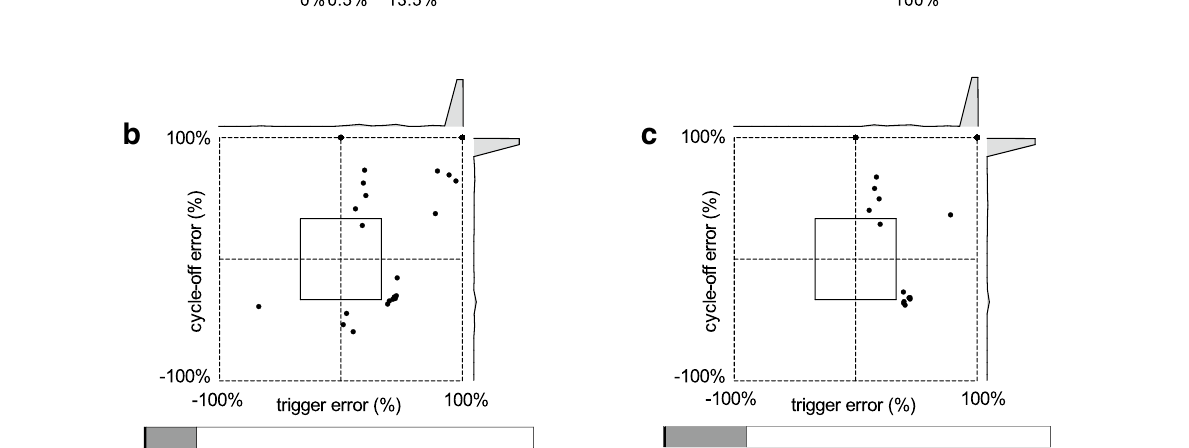
Fig. 5 Example of patient–ventilator interaction diagram with poor patient–ventilator interaction. Intra-breath patient–ventilator interaction dia- grams resulting from automated ( a ) and manual analysis by experts 1 ( b ) and 2 ( c ) are shown. Histograms of trigger and cycle-off errors are shown above and right of interaction diagrams. Stacked bar charts showing the relative distribution of events are depicted under the interaction diagrams. Corresponding NA and PAW tracings are shown in Fig. 3b